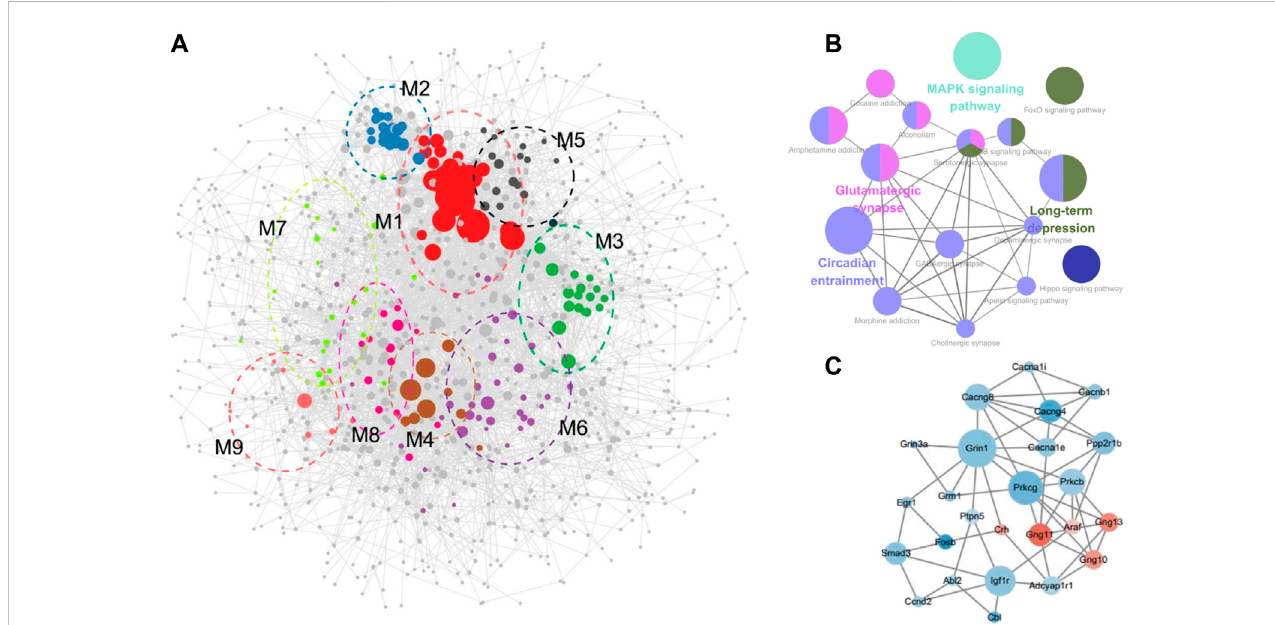
FIGURE 4 PPI network construction. (A) PPI network with modules comprising the DEGs regulated by cocaine and reversed by MET. (B) Visualization of the enrichment of KEGG terms associated with addiction using the ClueGO/CluePedia plugin from Cytoscape. (C) Subnetwork constructed with genes from modules 6 – 9 enriched in pathways associated with drug reward. Green, downregulated; red,